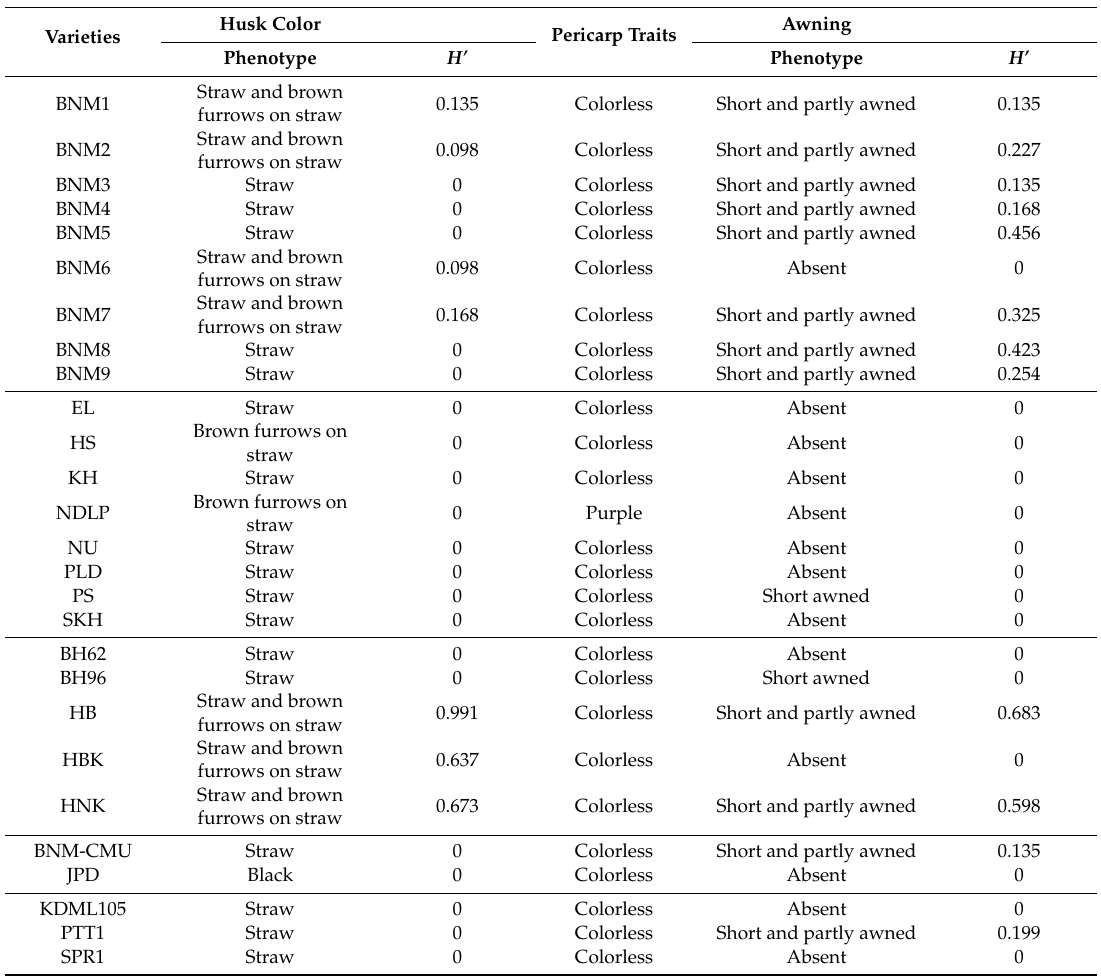
Table 3. Seed morphology of 22 landrace fragrant rice varieties, 2 breeding line varieties, and 3 check